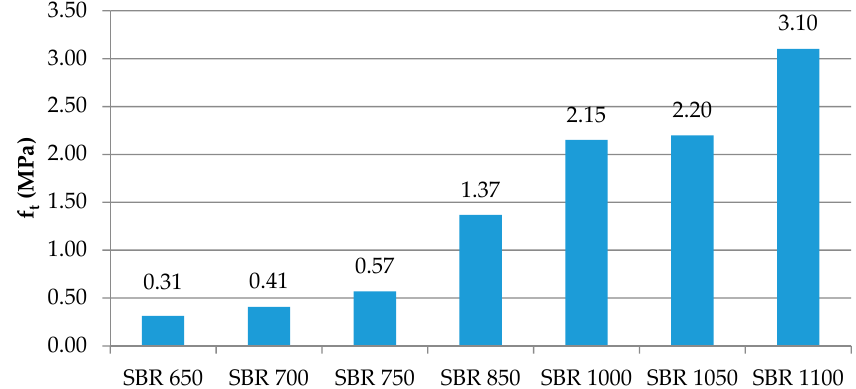
Figure 7. Tensile strength depending on the elastomeric material density.